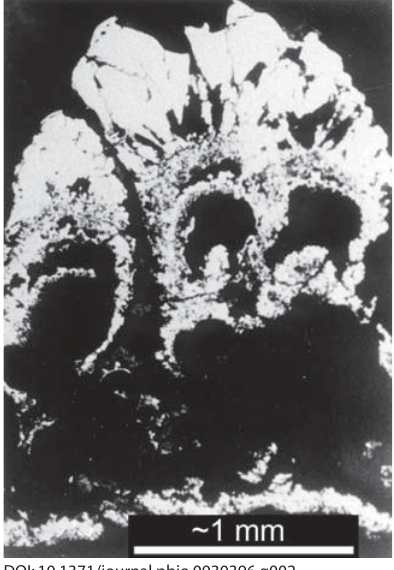
Figure 2. Botyroidal